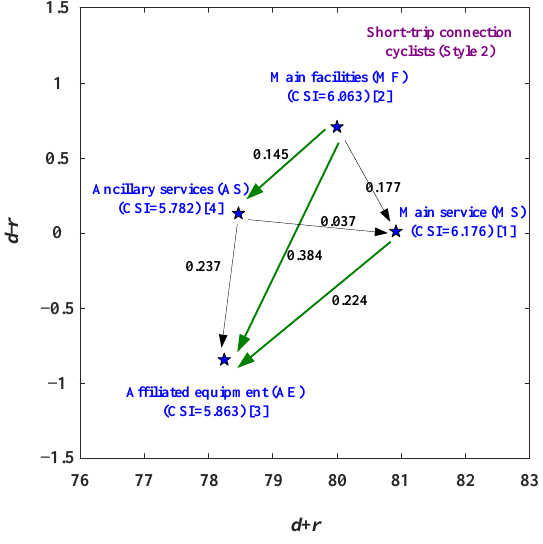
Figure 4. The development paths of short-trip connection cyclists (Style 2). Table 21. The adoption paths of short-trip connection cyclists (Style 2). Short-Trip Connection Cyclists (Style 2)